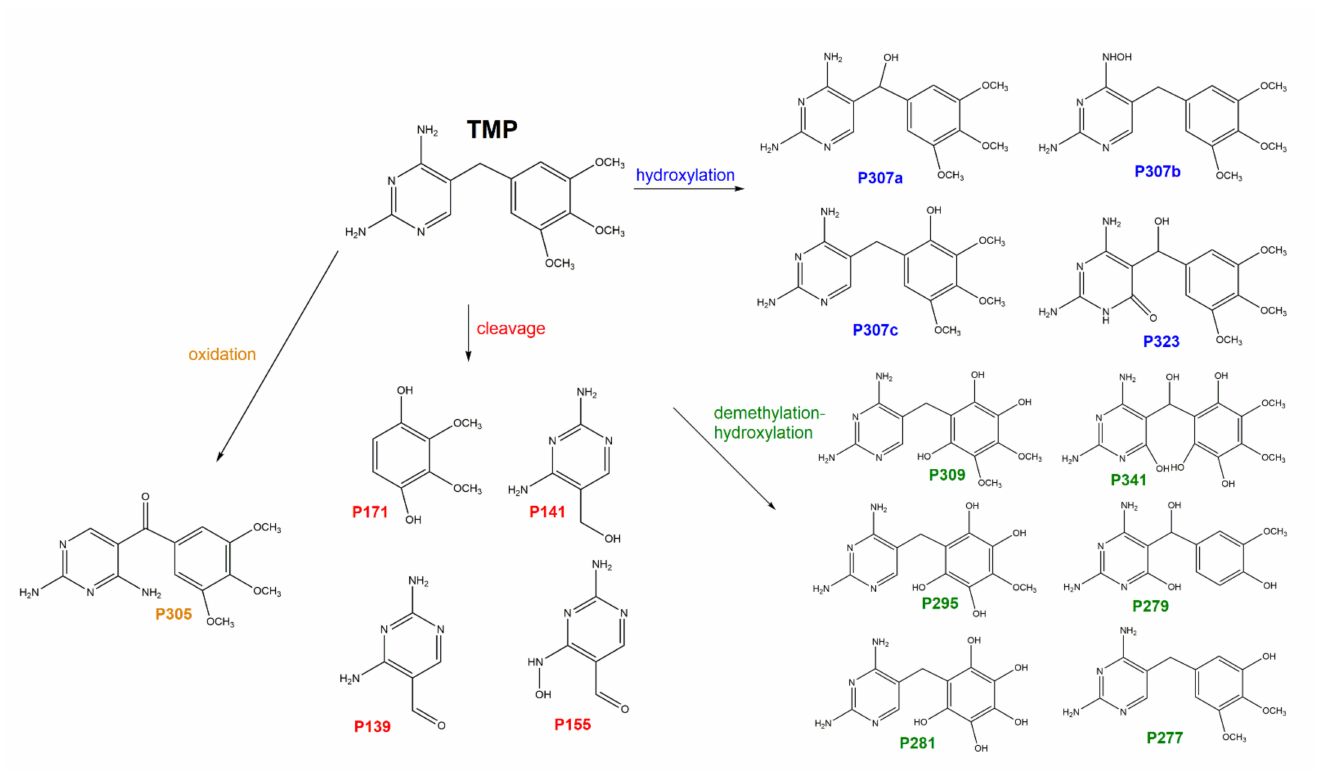
Scheme 3. Proposed degradation pathways of TMP in photocatalytic oxidation over TiO 2